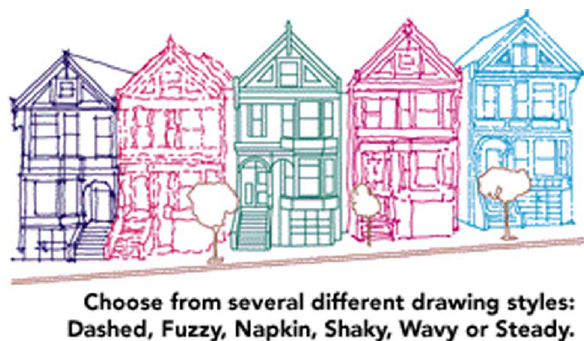
Figure 1. Generic detached suburban houses: “The Steady style looks like an architect’s steady hand” [9]. Photo: courtesy John Haley,